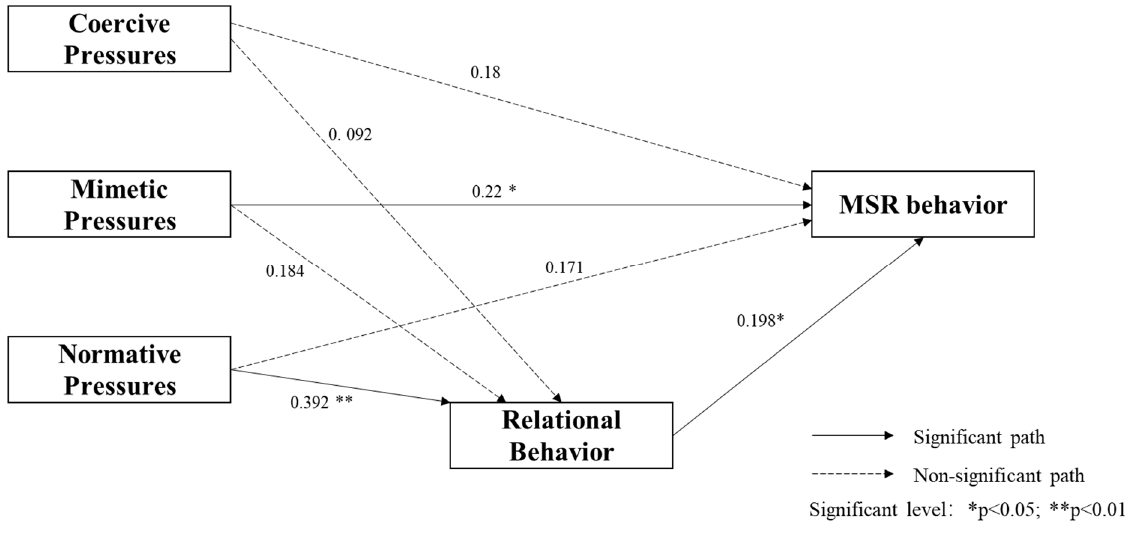
Figure 2. Theoretical model of institutional pressure on MSR behavior with relational behavior. Table 5. Summary of Model 4.